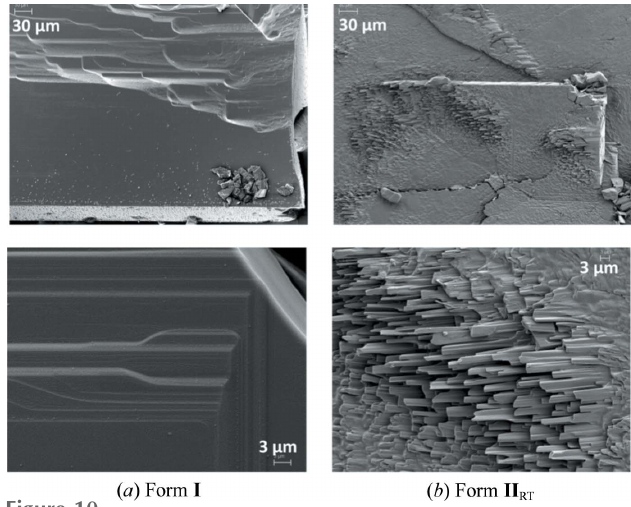
Figure 10 SEM images of the microstructures of form I and form II RT